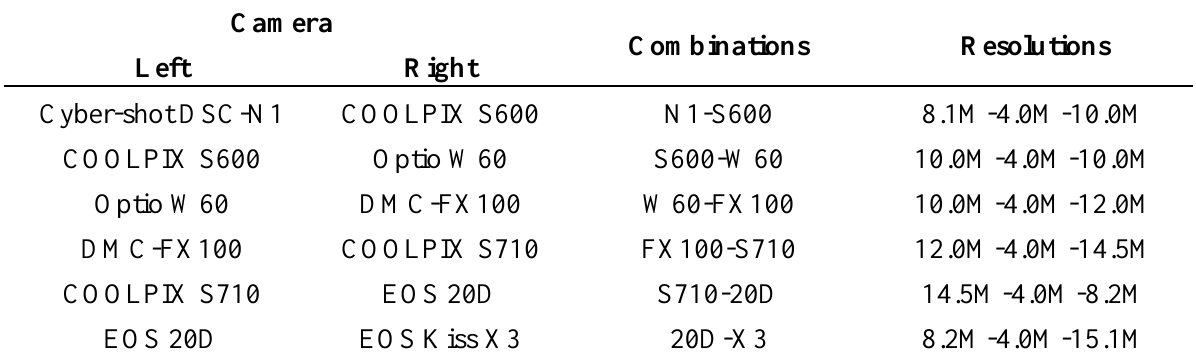
Table 2. Combinations of digital cameras.